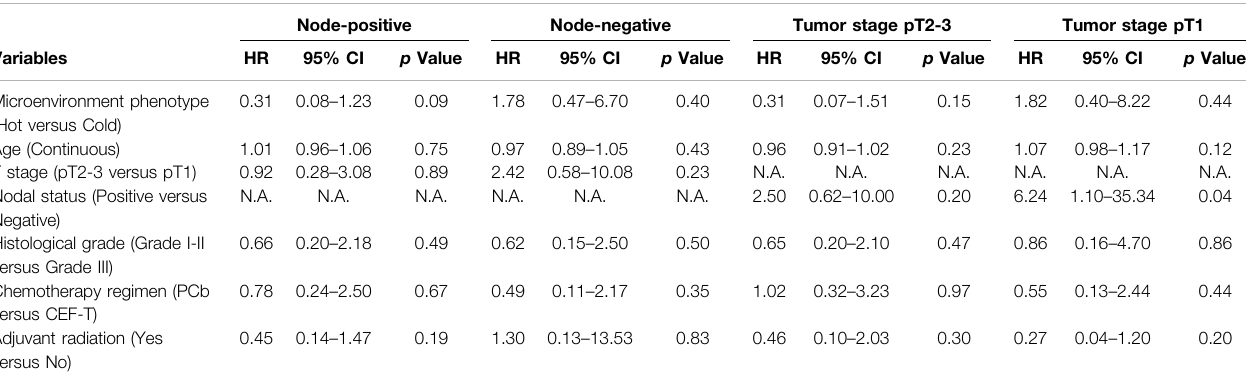
TABLE 3 | Multivariate analysis of microenvironment phenotypes in TNBC. Node-positive Node-negative Tumor stage pT2-3 Tumor stage